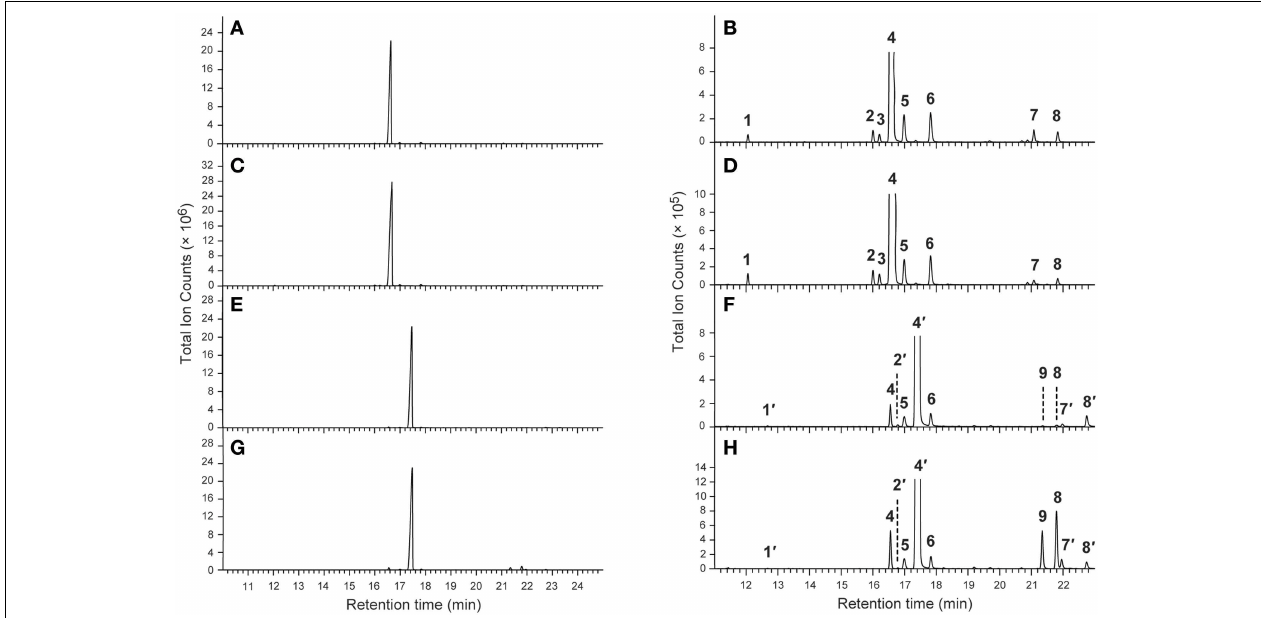
FIGURE 1 | Typical GC-MS chromatograms of the cis - and trans -alkaloid fractions. (A,B) The cis alkaloid fraction of workers; (C,D) The cis alkaloid fraction of alate queens; (E,F) The trans alkaloid fraction of workers; (G,H) The trans alkaloid fraction of alate queens.